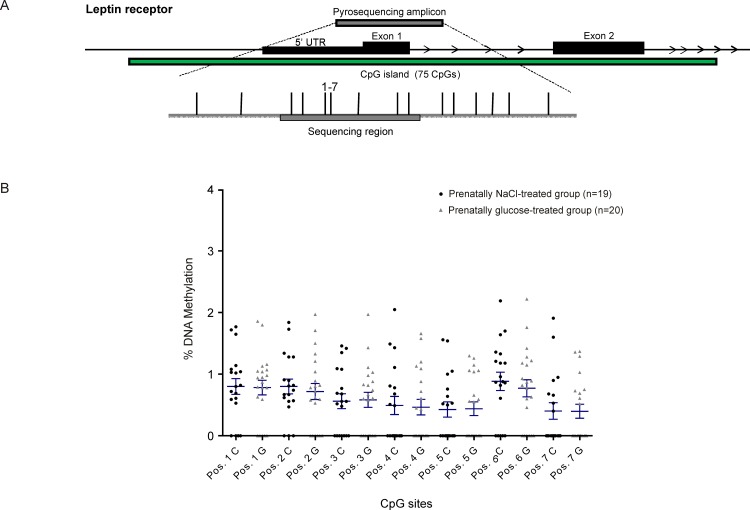
Leptin receptor (LEPR).Schematic illustration of sequence map of the leptin receptor (LEPR) gene promoter region with chromosomal location of pyroassay (A), and corresponding DNA methylation levels at individual CpG sites for prenatally NaCl-treated controls (black) and the prenatally glucose-treated group (gray) (B).